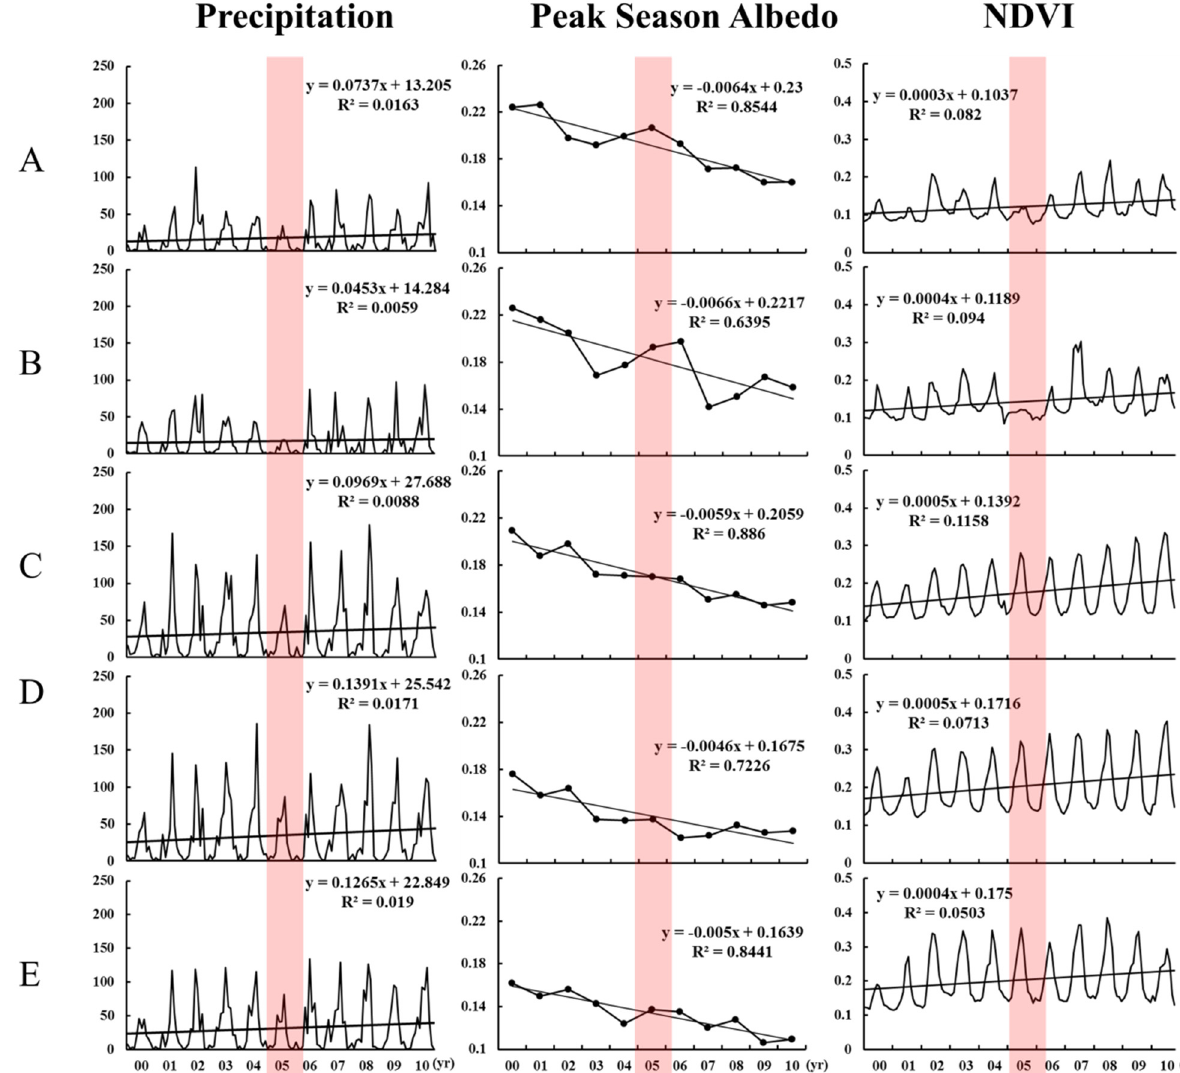
Figure 9. Time-series variation of monthly precipitation (mm), peak season albedo (%) and NDVI at five interest regions (3 × 3 pixels). The red bar indicates the drought year. The letters from A to E are interest Regions: ( A ) Etuoke Qi. ( B ) Lingwu country. ( C )Shenmu country. ( D ) North of Shenmu. ( E ) Dongsheng